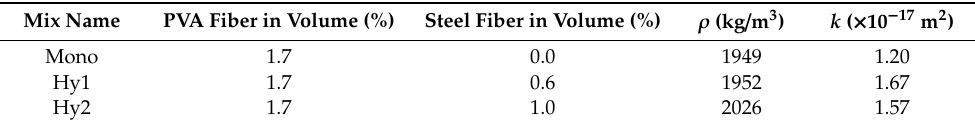
Table 2. Volume fraction of fibers and physical parameters of di ff erent engineered cementitious composites (ECC)